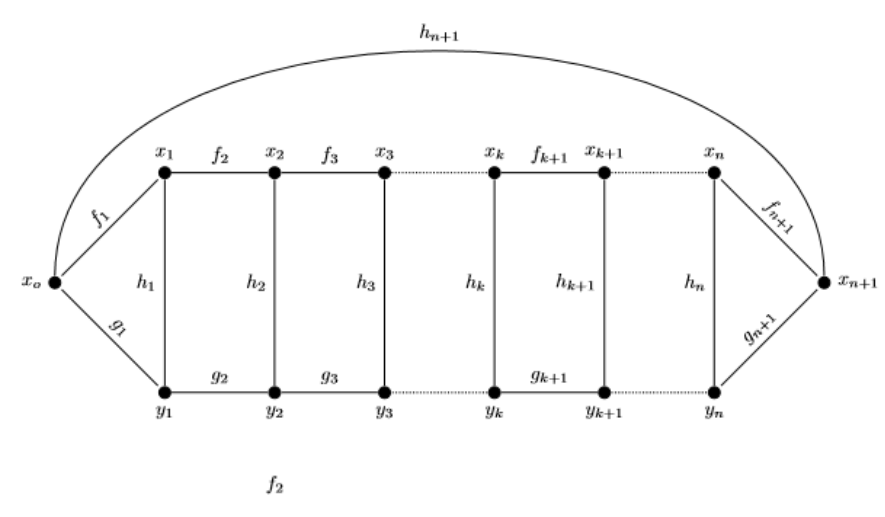
Figure 1. The necklace graph N e